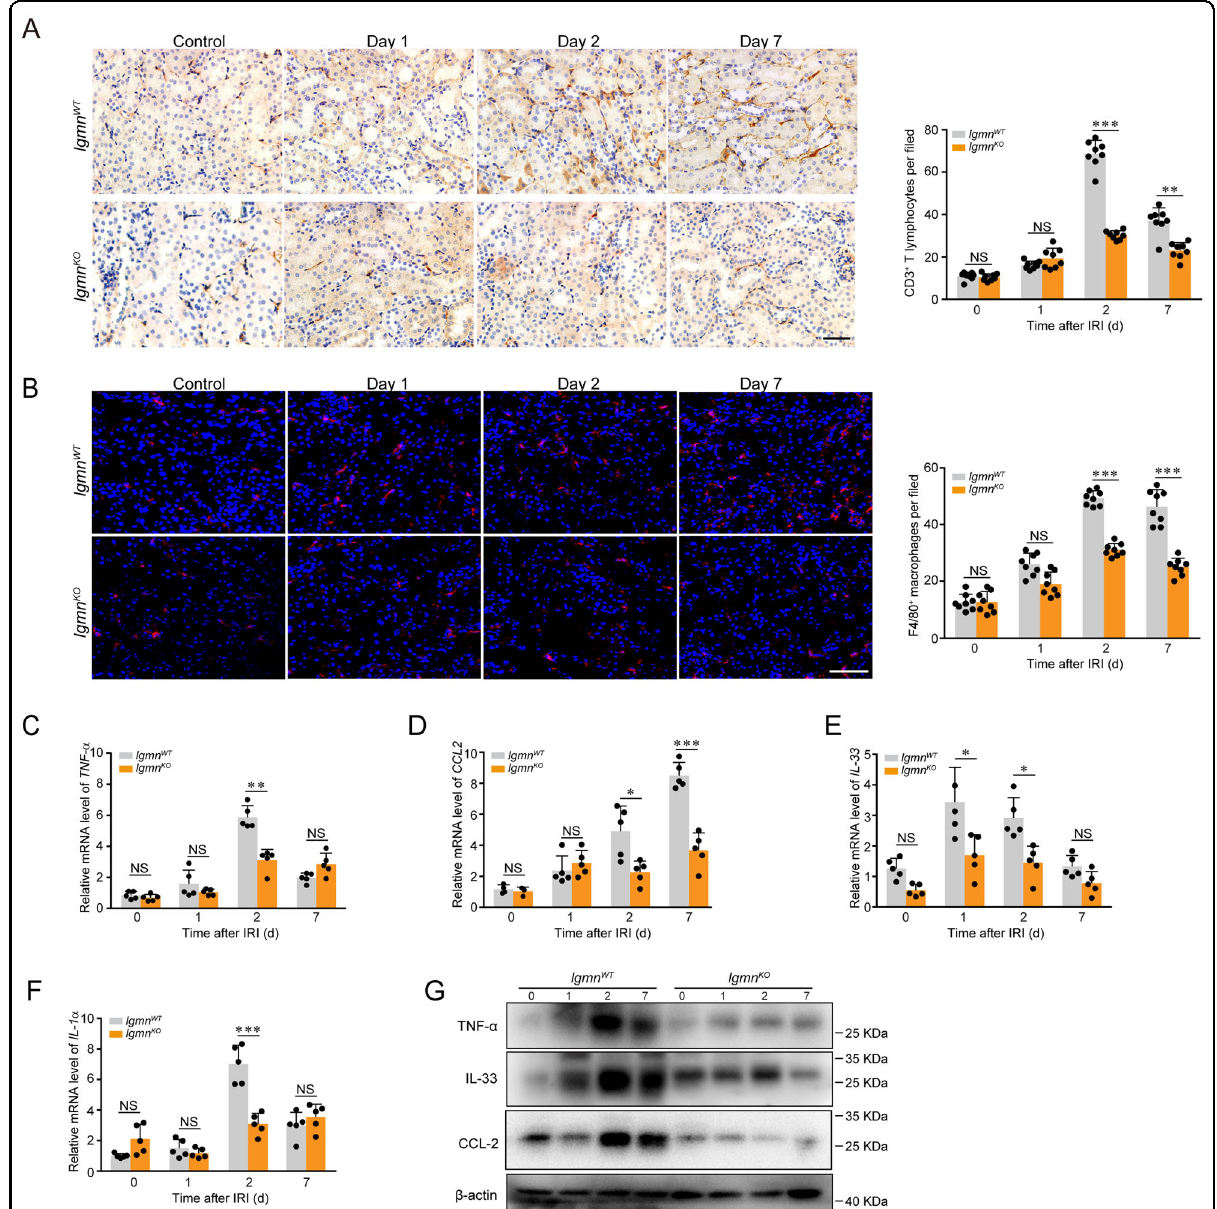
Fig. 2 Legumain de fi ciency decreases in fl ammatory reactions in the mouse model of IRI. Lgmn WT and lgmn KO mice were randomized to 40 minutes of bilateral ischemia ( n = 8). Collection of kidney samples was performed as described in Fig. 1. A Representative images (left panel) and quanti fi cation (right panel) of CD3-positive cells in AKI kidneys of lgmn WT and lgmn KO mice. Scale bar, 50 μ m. B Representative confocal images (left panel) and quanti fi cation (right panel) of kidney sections stained for F4/80 (red) and with DAPI (blue). Scale bar, 50 μ m. C – F qPCR analysis of mRNA expression of in fl ammatory genes TNF- α , CCL-2 , IL-33 , and IL-1 α in kidneys of lgmn WT and lgmn KO mice. G Protein levels of in fl ammatory factor TNF- α , CCL-2, IL-33 in kidney samples assessed by western blotting. All data are expressed as the mean ± SD. * P < 0.05, ** P < 0.01, *** P < 0.001; two- way